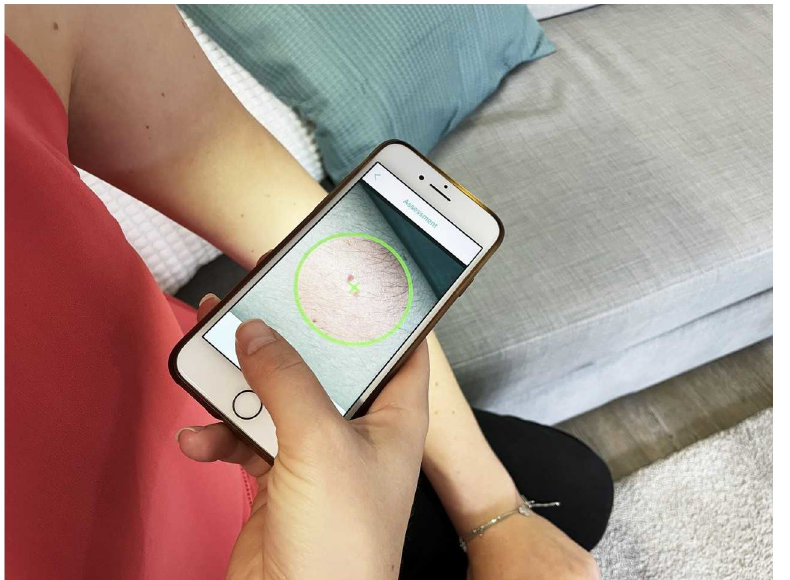
Fig 3. Easy use of the algorithm by the patient on the